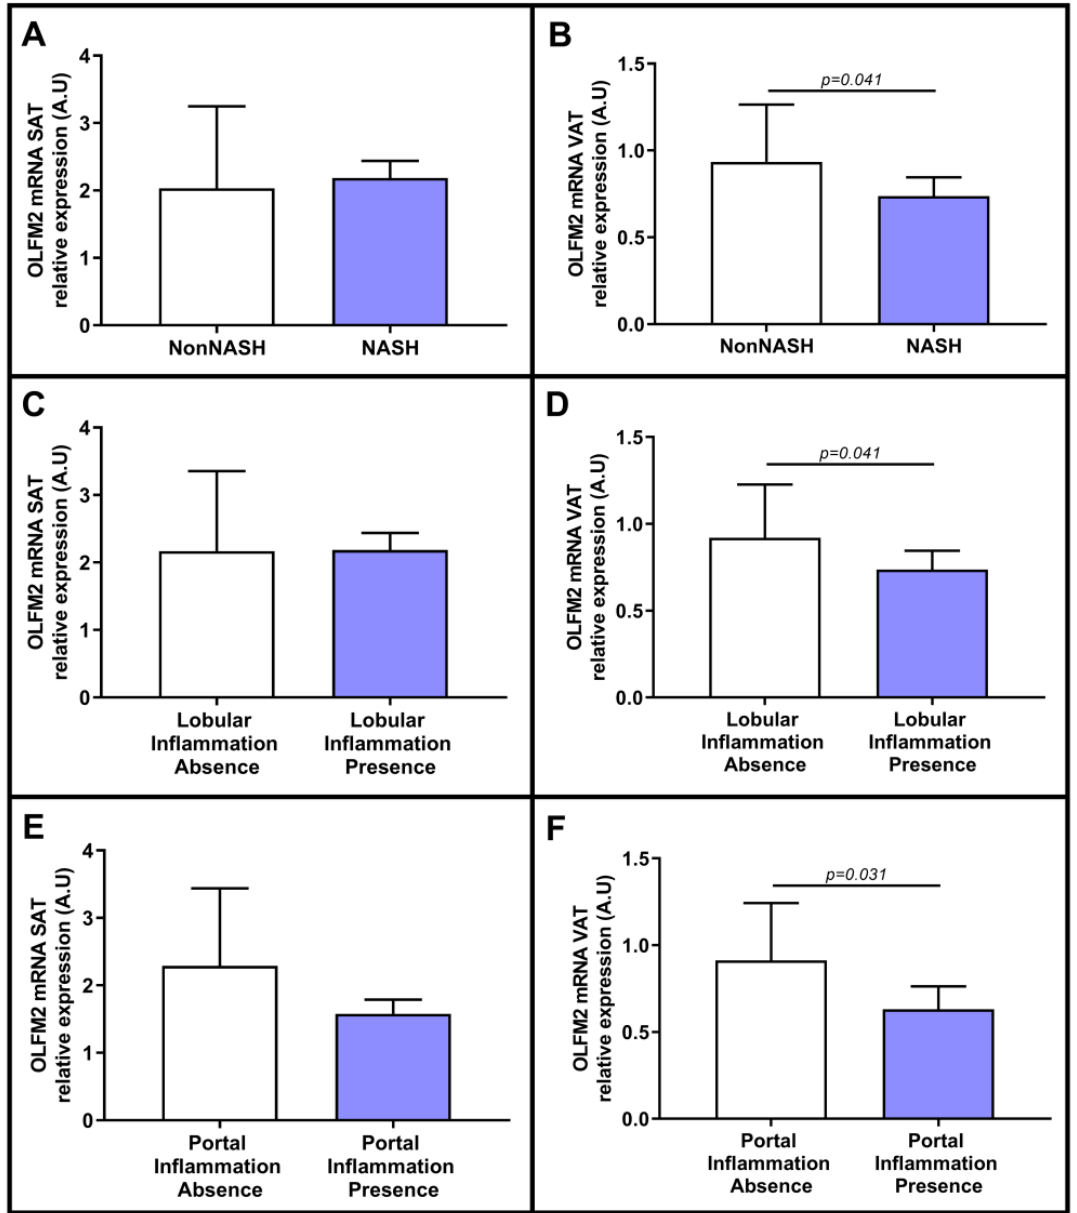
Figure 5. Comparison of mRNA expression of OLFM2 in SAT ( A ) and VAT ( B ) between absence or presence of NASH. Differential relative mRNA abundance of OLFM2 in SAT ( C ) and VAT ( D ) between absence or presence of lobular inflammation and portal inflammation absence or presence ( E ) in SAT and ( F ) in VAT. OLFM2, olfactomedin 2; VAT, visceral adipose tissue; SAT, subcutaneous adipose tissue; NASH, nonalcoholic steatohepatitis; A.U, arbitrary units. Mann–Whitney test was used to calculate differences between groups, and p < 0.05 was considered statistically significant.